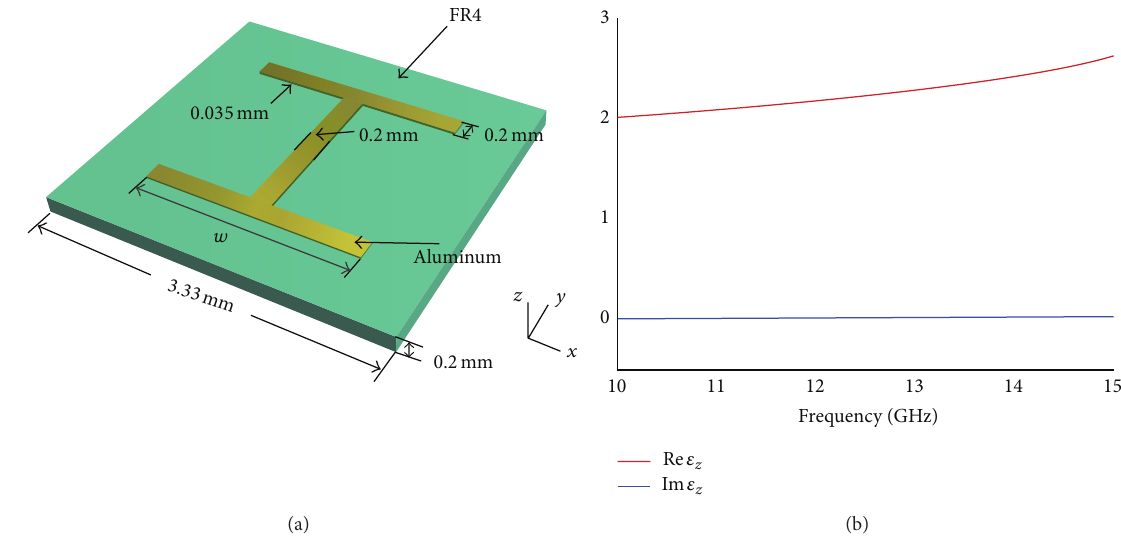
Figure 2: The unit cell of the modified Luneburg lens. (a) The perspective view. (b) The effective 𝜀 𝑧 of the unit.